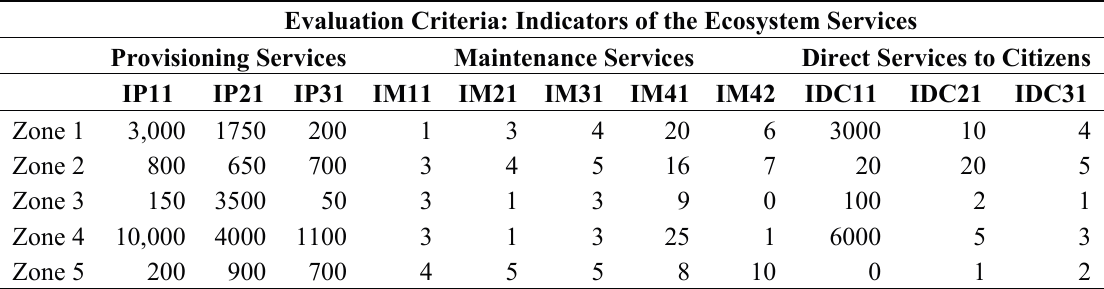
Table 3. Evaluation table for five zones of the Serra d’Espadà natural park. Evaluation Criteria: Indicators of the Ecosystem